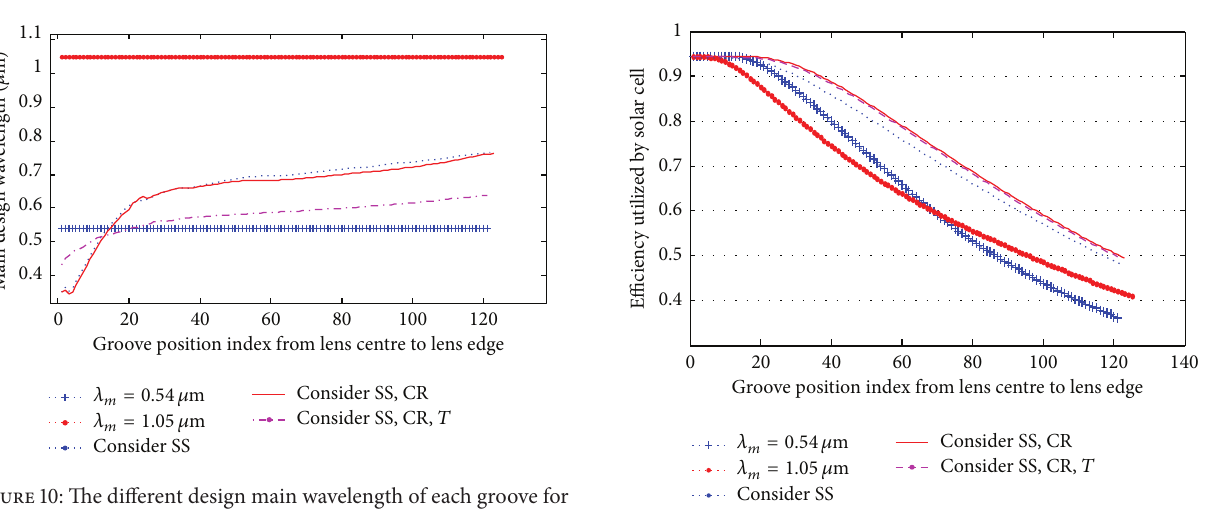
design and the novel design (SS: solar spectrum; CR: cell response; T : temperature).